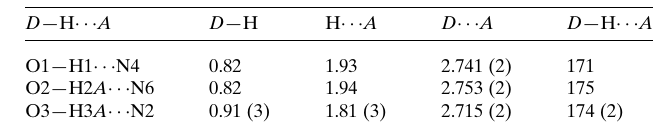
Table 1 Hydrogen-bond geometry (A˚ , (cid:4) ).